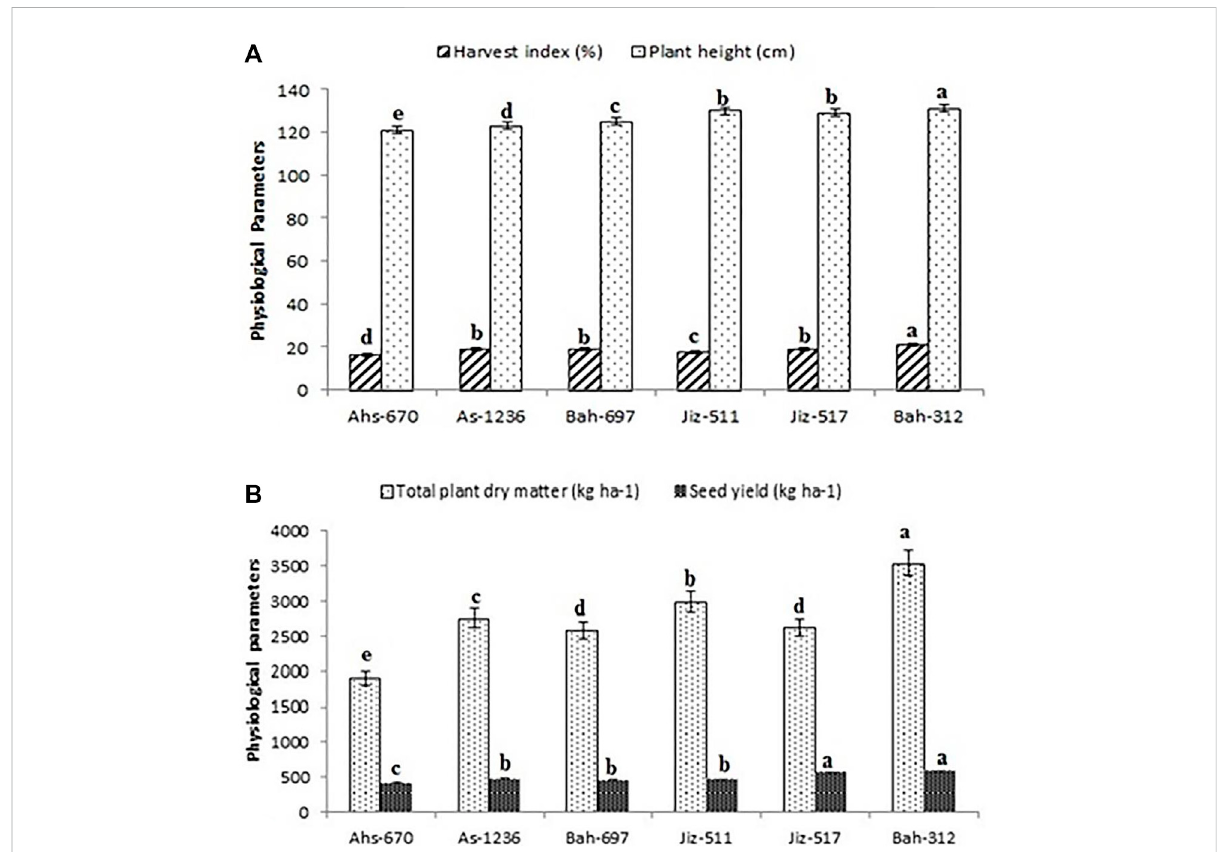
FIGURE 1 Physio-morphological parameters for different genotypes of sesame. (A) ; harvest index (%) and Plant height (cm). (B) ; Total plant dry matter (kg ha-1)andseedyield(kgha-1).Valuesaretheaveragesofthreereplicates±SD.Differentlettersindicatesigni fi cantdifferencesaccordingtoDuncan ’ s multiple range tests ( p < 0.05